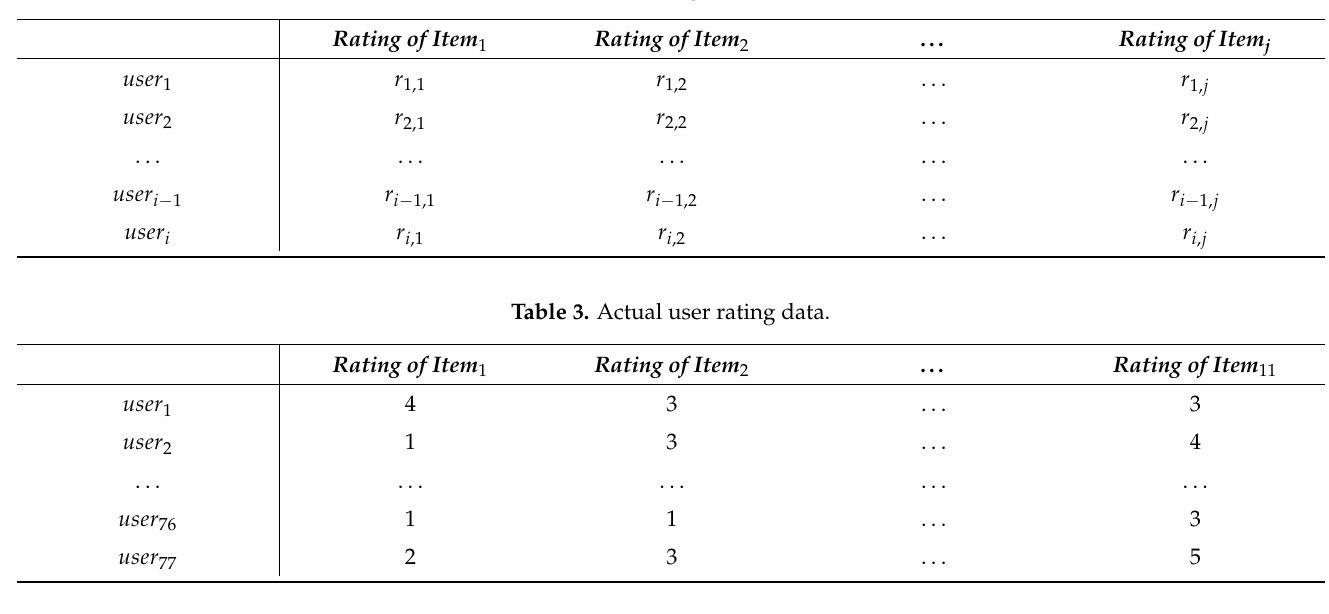
Table 2. User rating on each item.